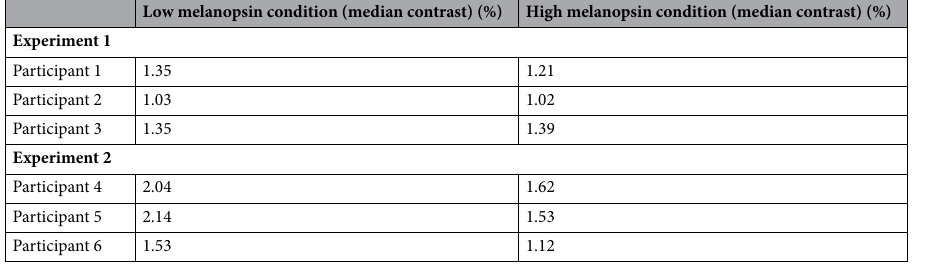
Table 1. Participant flicker LMS contrasts at detection threshold. Median (over sessions) threshold contrast for LMS flicker in low, and high melanopsin